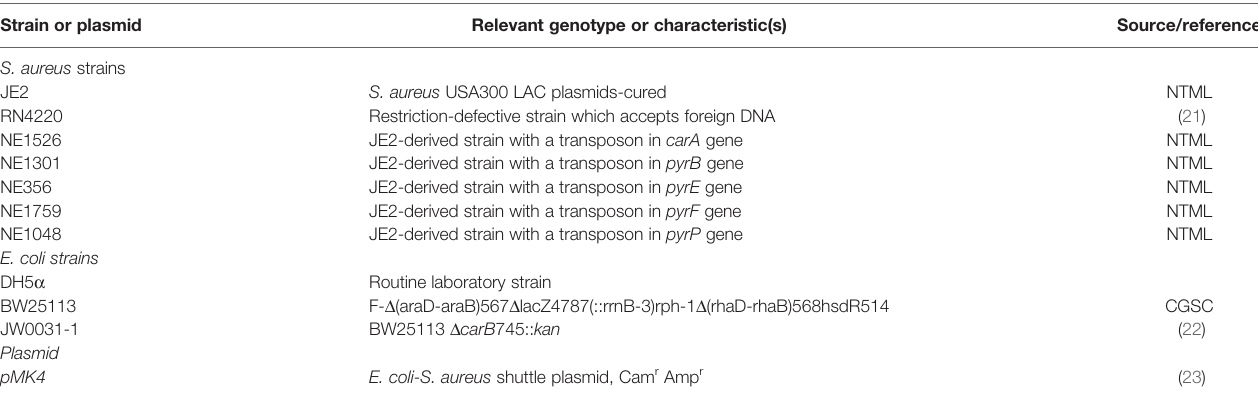
TABLE 1 | Bacterial strains and